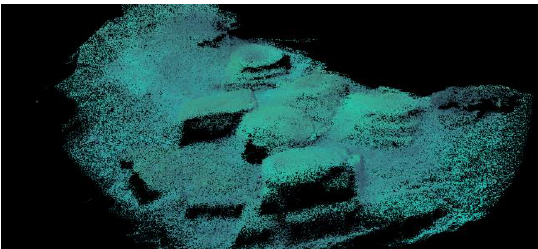
Figure 13. Lipari after global registration